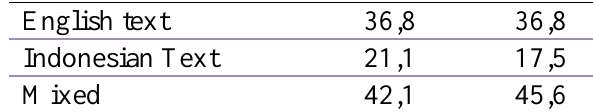
Table 2: Text Preparation and Reviewing of the Students